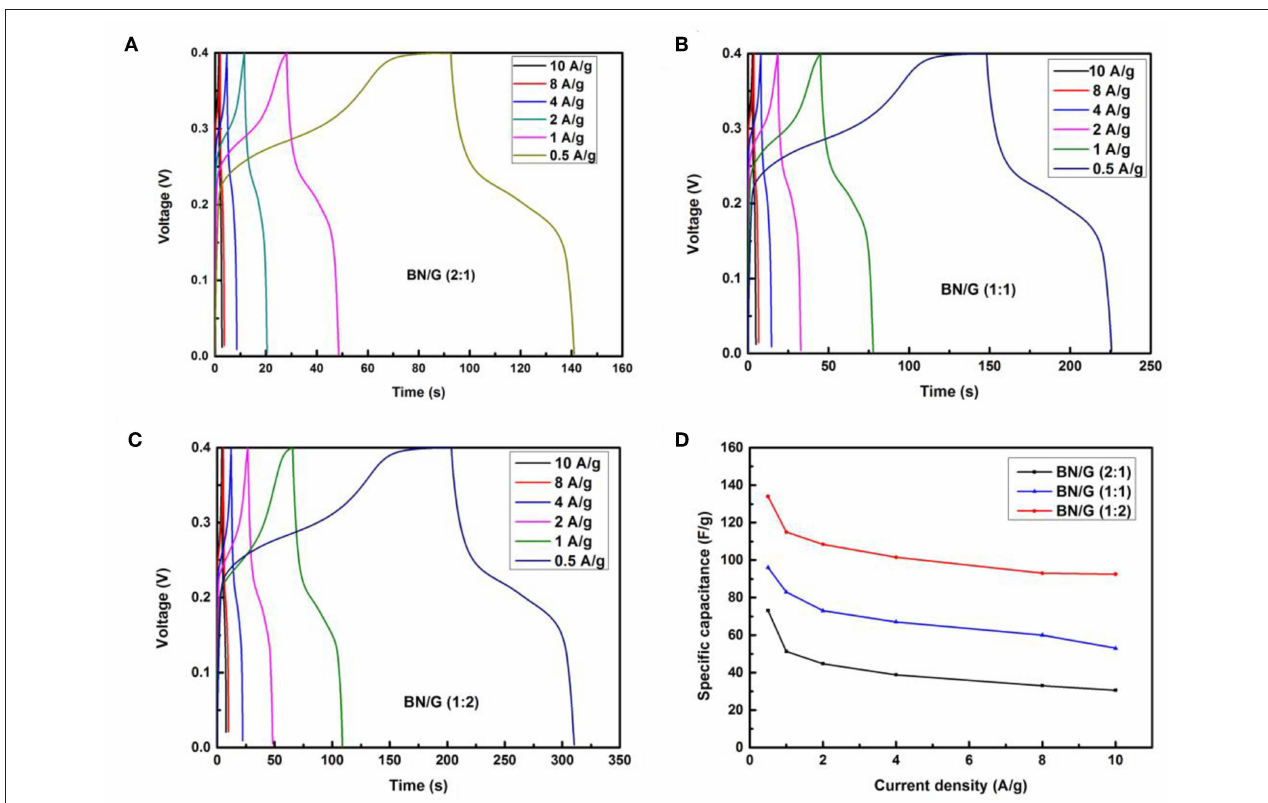
FIGURE 6 | Galvanostatic charge–discharge curves for all BN/G at different current densities: (A) BN/G(2:1), (B) BN/G(1:1), (C) BN/G(1:2), and (D) specific capacitance of all BN/G as a function of discharge current.